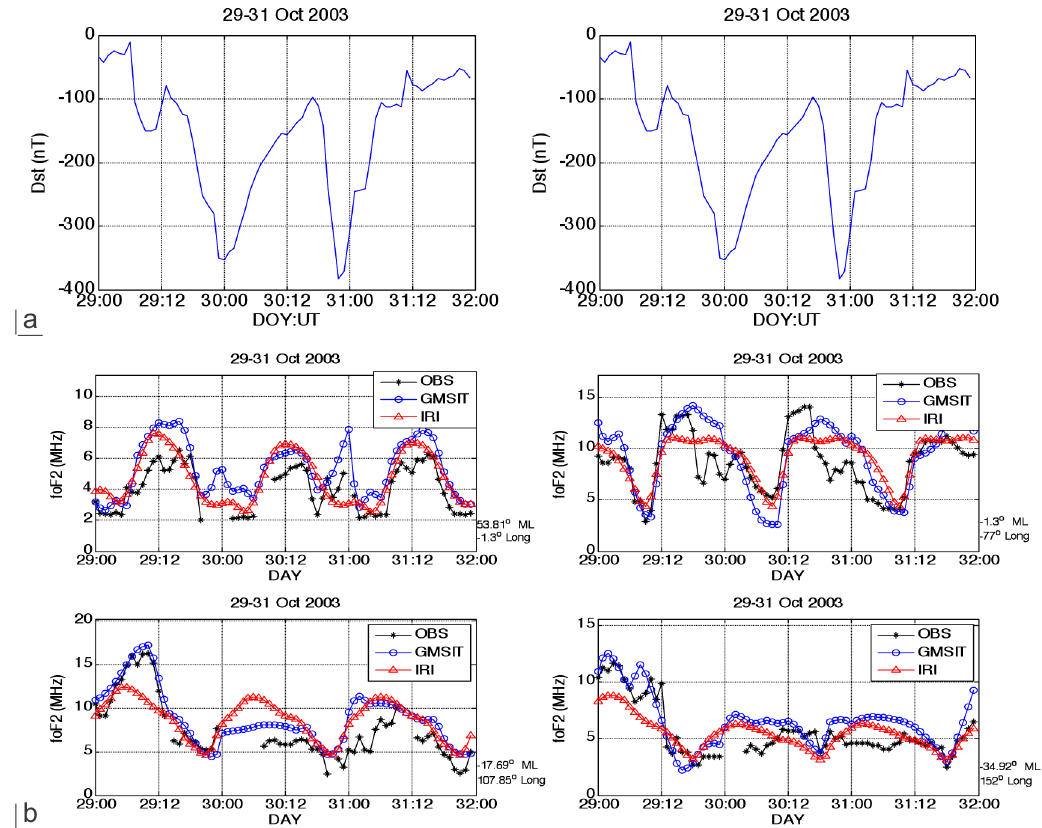
Figure 5. (a) Dst index during period of great geomagnetic storm and (b) estimated foF2 from GMIST, IRI, and ionosonde observations at ionospheric stations of different regions of the globe. The geomagnetic latitude and geographic longitude of each station is given at the low- right edge of each